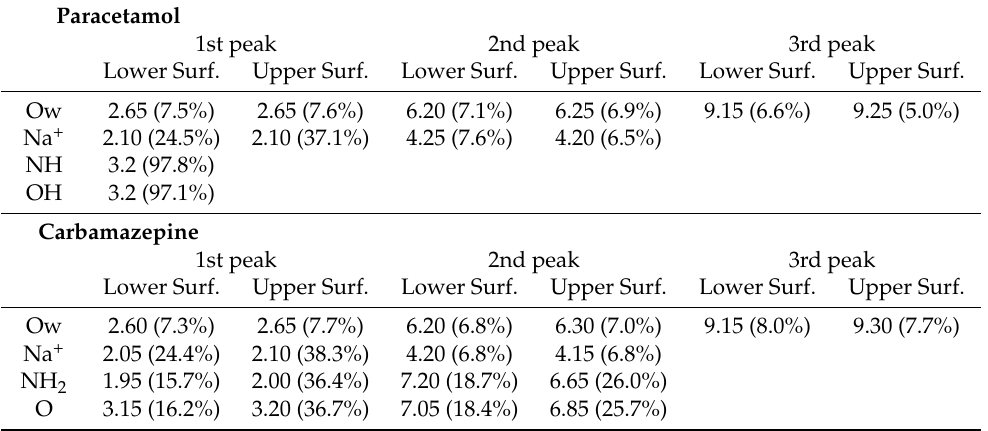
Table 1. Density profile data (see Figure 4). Peak coordinates (along z ) and densities are given in Å. In parentheses, the percentage of the total atom/molecule density is reported.